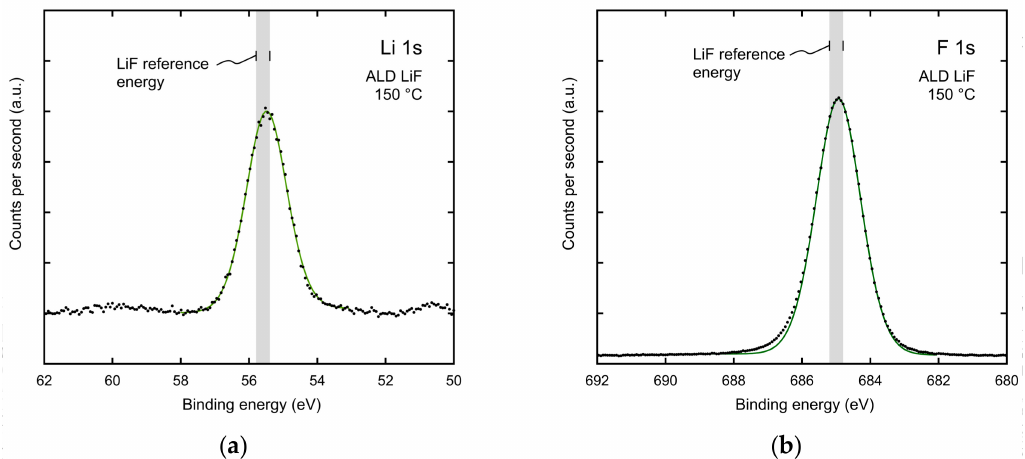
Figure 4. High-resolution XPS spectra (symbols) and the background-adjusted best-fit (solid line) of the ( a ) Li 1s level, and ( b ) the F 1s level, for a 3 nm ALD LiF thin film deposited on Si at a substrate temperature of 150 ◦ C. Shaded regions highlight expected binding energies for LiF from reference spectra